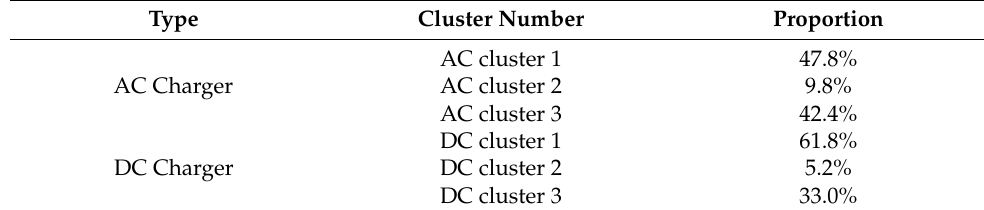
Figure 2. EV-user segmented groups of AC chargers. Table 1. EV-user segmentation results.